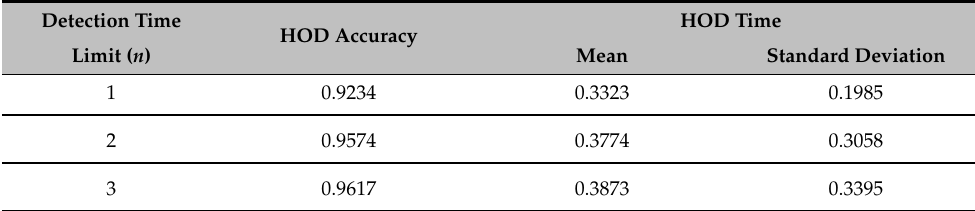
Table 6. HOD accuracy and time on the test set (time window size = 10). The unit detection time limit and HOD time is second.